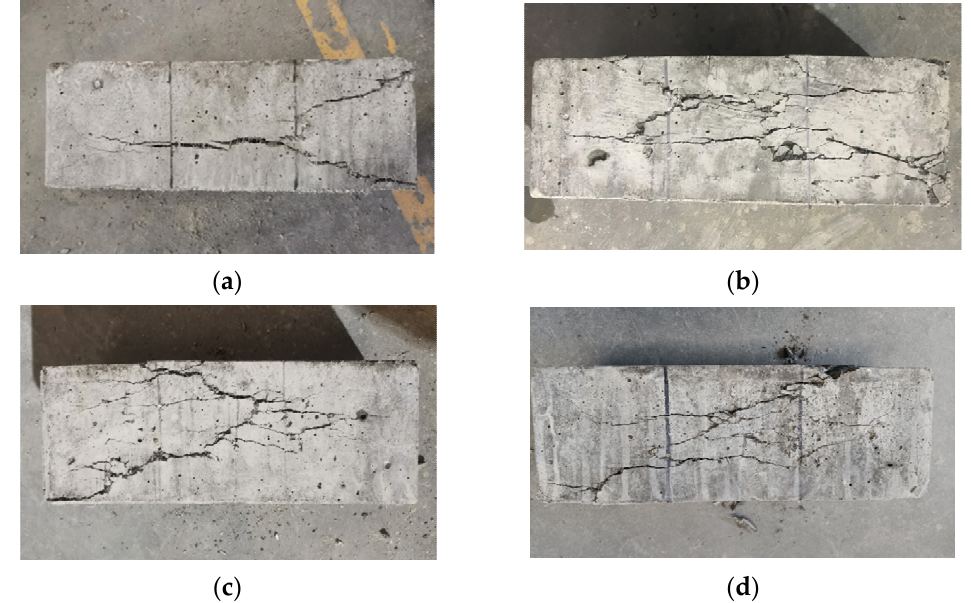
Figure 12. Failure performance of NF specimens with different ages after axial compressive test: ( a ) 3 d; ( b ) 7 d; ( c ) 14 d; and ( d ) 28 d.